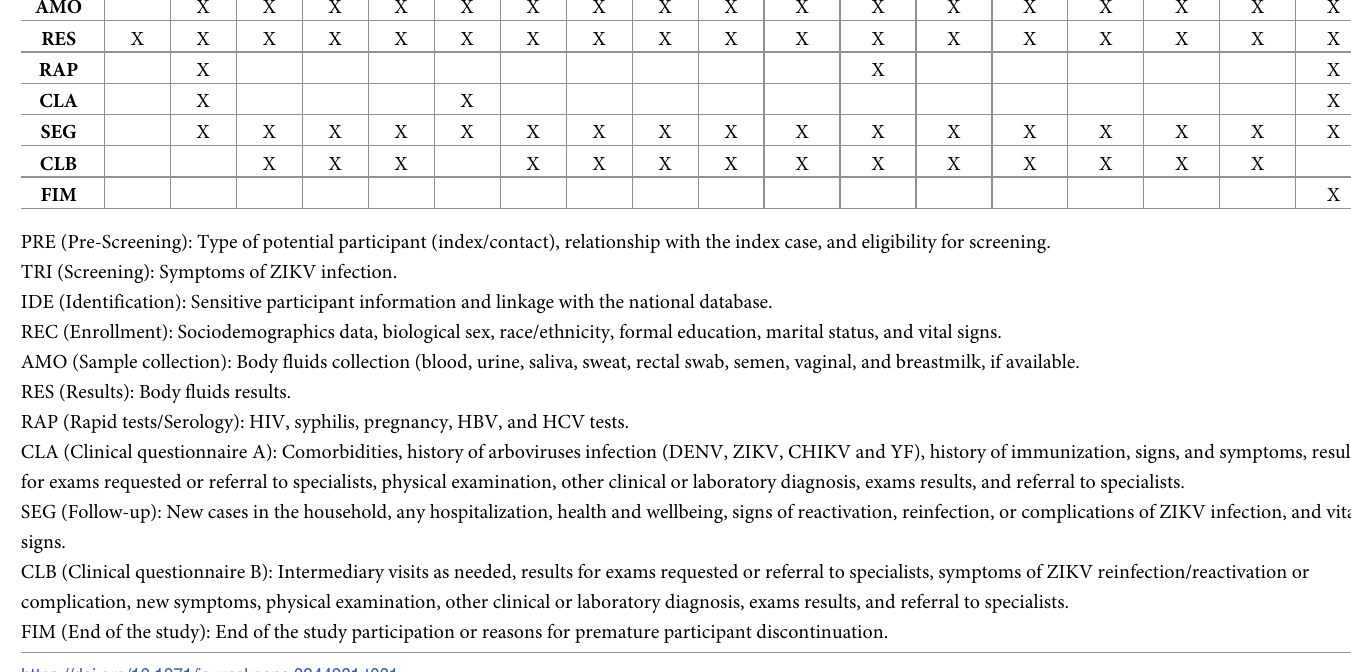
Table 1. Summary of questionnaires and data collection for ZIKABRA study.